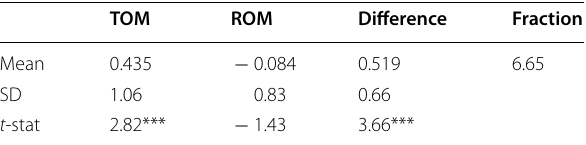
Table 5 T-test of means for “Turn-of-the-Month-Effect” of year 2015